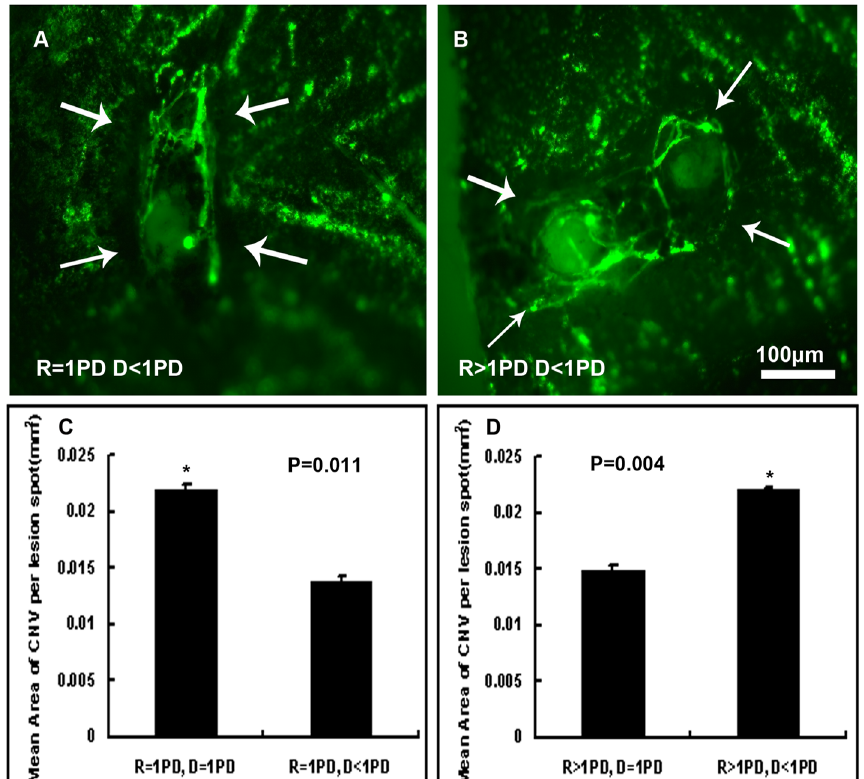
Figure 7. Interaction of NV observed in laser spots delivered further away from the optic disc and closer together. 16–20- week-old female C57BL/6 mice were given laser photocoagulation spots in the retinas with distance of 1PD from the optic disc and less than 1PD from each other, or 1PD from each other, as well as with distance more than 1PD from the optic disc and 1PD from each other, or less than 1PD from each other of each eye with a cover slide placed on the cornea as a contact lens. After two weeks, mice were perfused with fluorescein-labeled dextran and choroidal flat mounts were examined by fluorescence microscopy and the area of CNV was measured by image analysis. Each CNV lesion area was calculated as a single experimental value so as to investigate whether the distance between two adjacent laser spots would affect the area of CNV induced by photocoagulation. Statistics analyzed by student’s t-test suggested interactions occurred when spots were given further away (1PD away from the optic disc) and closer together (less than 1PD from each other; n=5mice/group; R: distance from laser spots to optic disc, D: distance between the two adjacent laser spots).